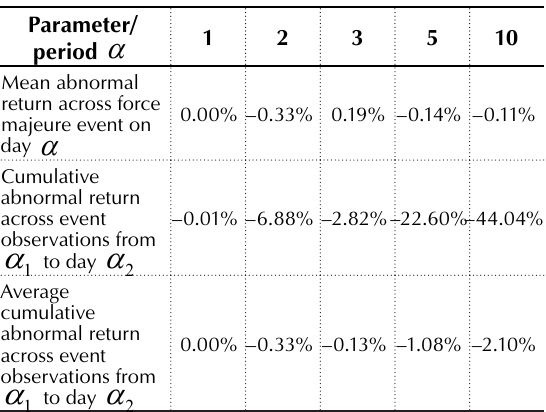
Table 14. Cumulative abnormal returns for the PFST returns over the period 1991–2018: technological disasters